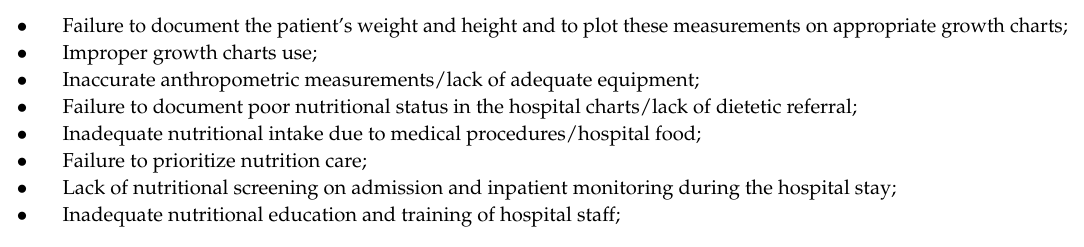
Table 3. Hospital practices that may worsen the nutritional status of hospitalized paediatric